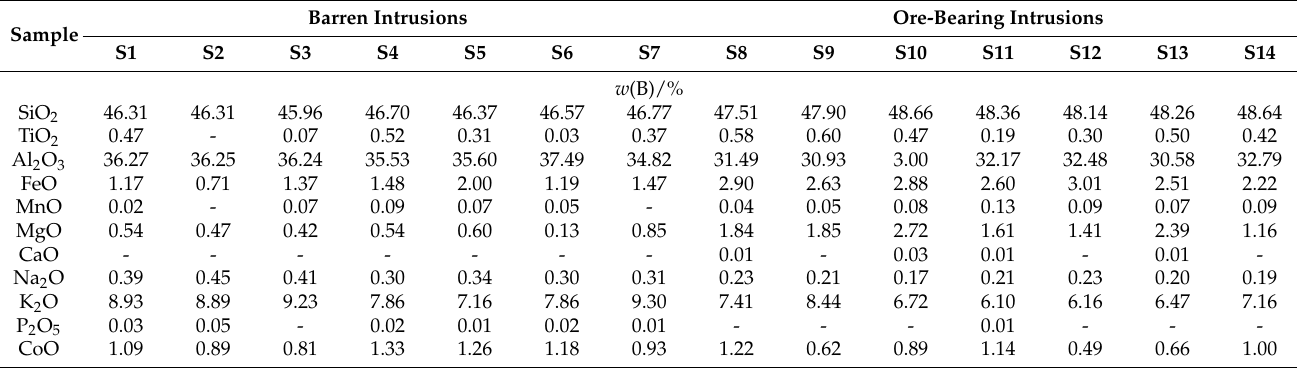
Table 1. Results of the electron microprobe analysis of white